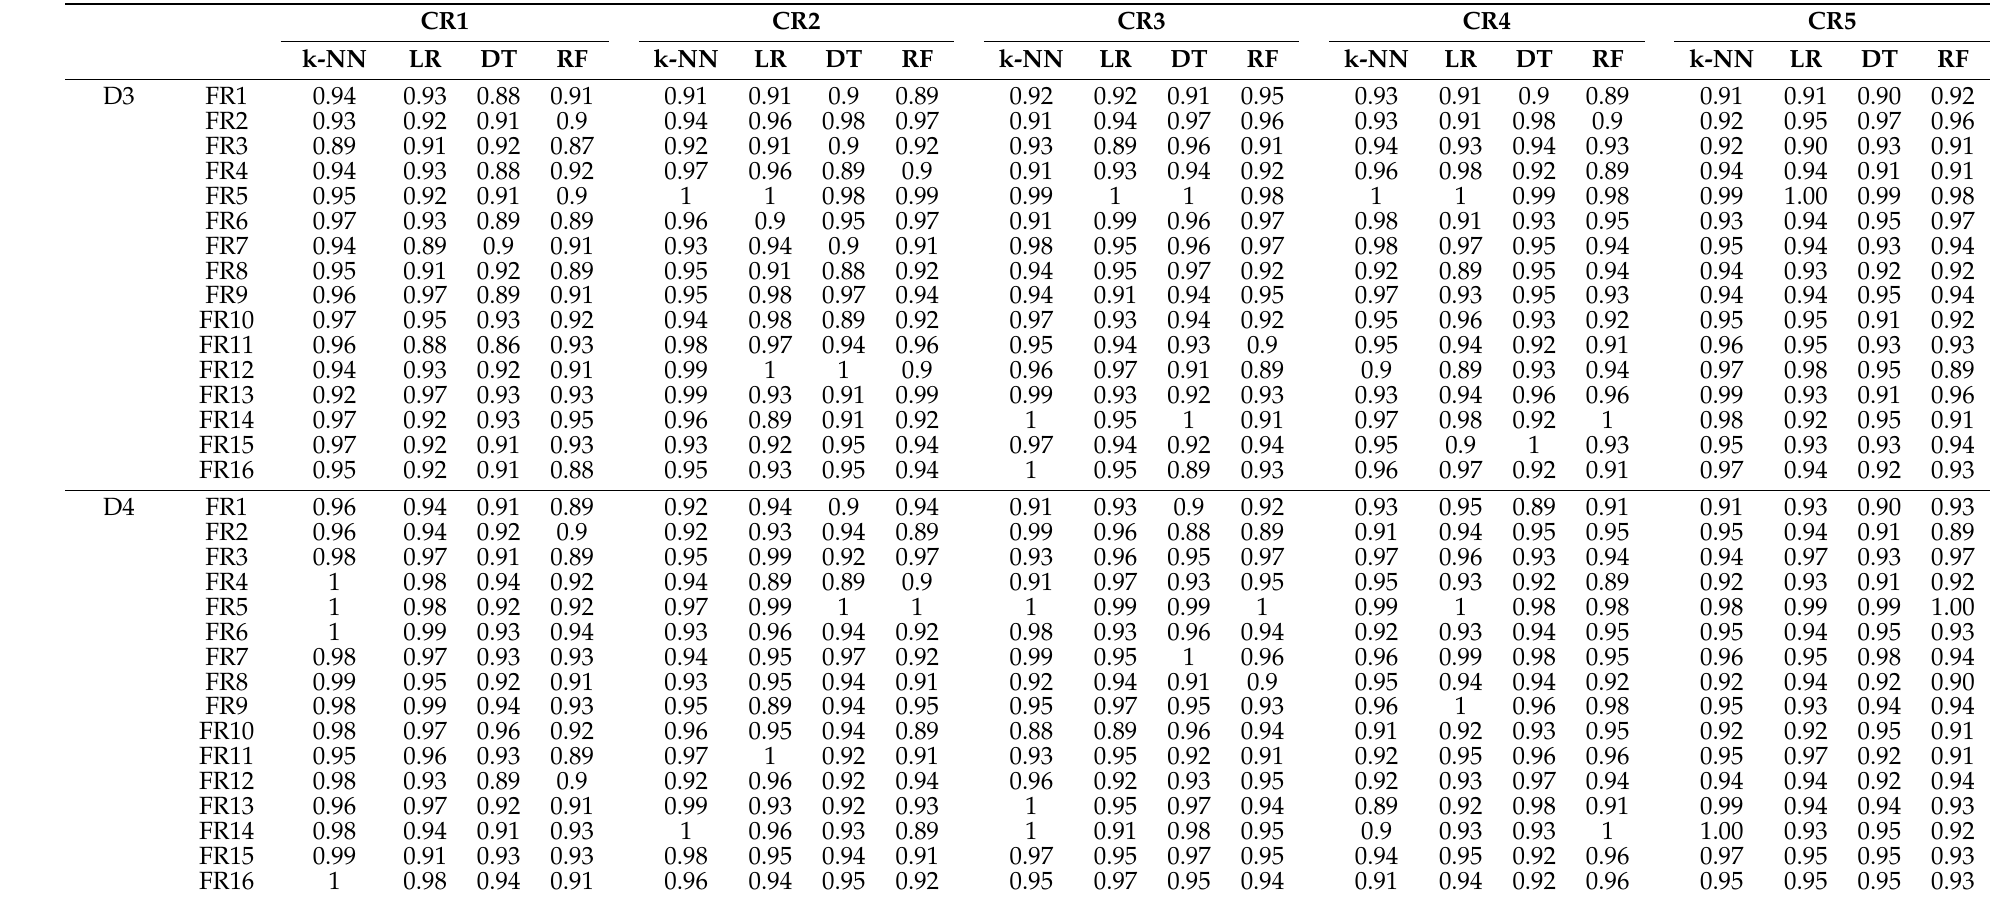
Table 4. Classification Results of Four Datasets By Using k-NN, LR, DT, and RF Classifier with Different Feature Ranking Techniques